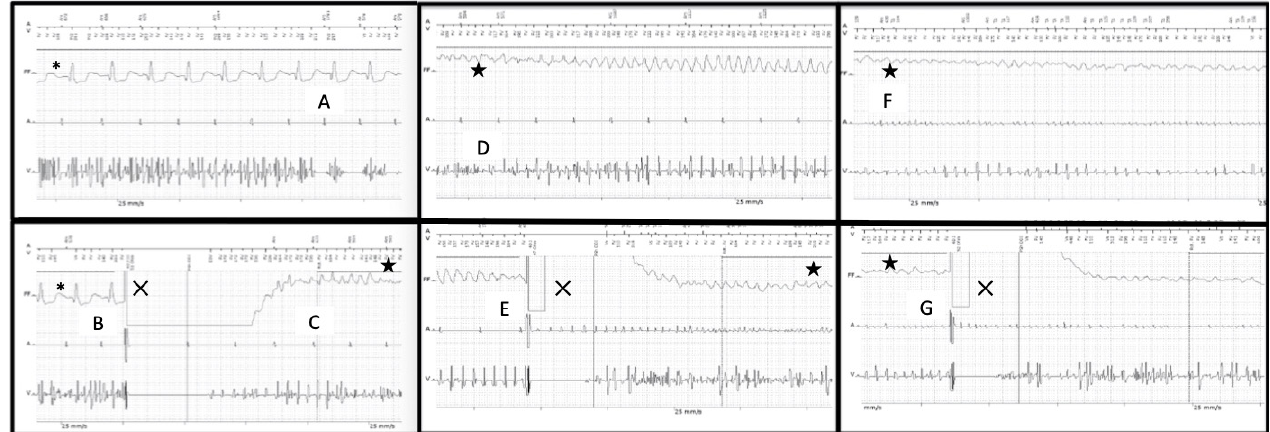
Fig. 1 – Inappropriate detection of ventricular fibrillation due to noise in the ventricular lead (A), followed by inappropriate shock therapy (B), and implantable cardioverter defibrillator-induced ventricular fibrillation (C). Ventricular fibrillation (D and F) and unsuccessful shock therapy (two episodes – E and G). * sinus rhythm; X shock therapy; ventricular